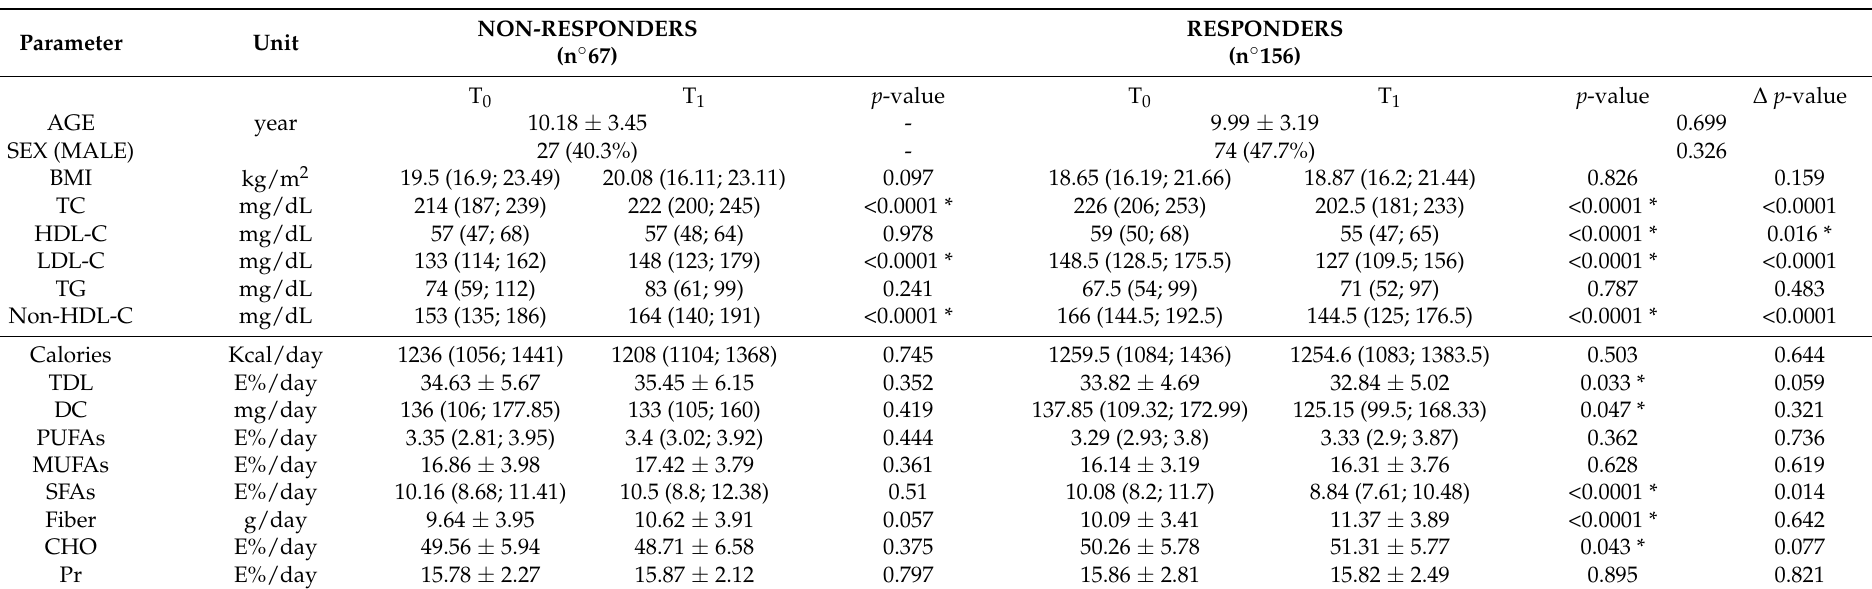
Table 2. Lipid profile and daily dietary intake at baseline (T0) and at 6 months follow-up (T1) and estimated changes (Delta) between the Responder Group and the Non-Responder